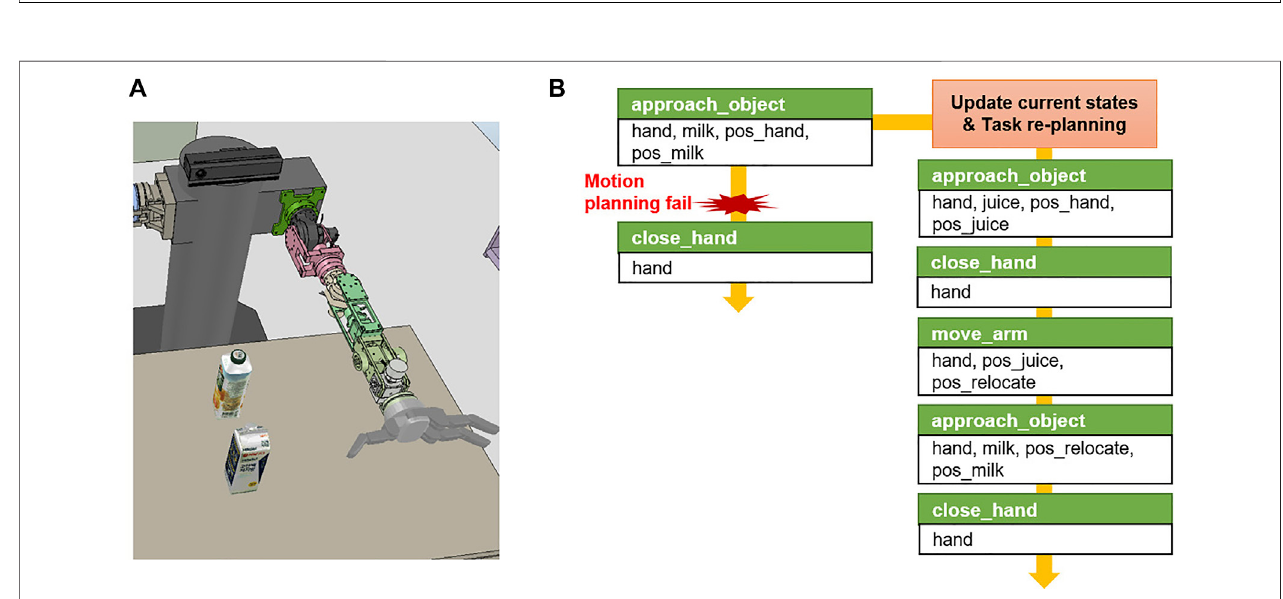
FIGURE8| Example oftaskre-planning inthepickand placetaskdomain. (A) Initialsimulationenvironmentscene. (B) Whentherobotfailedtomotionplanningto execute approach _ object action, the task manager re-plans primitive action sequence.